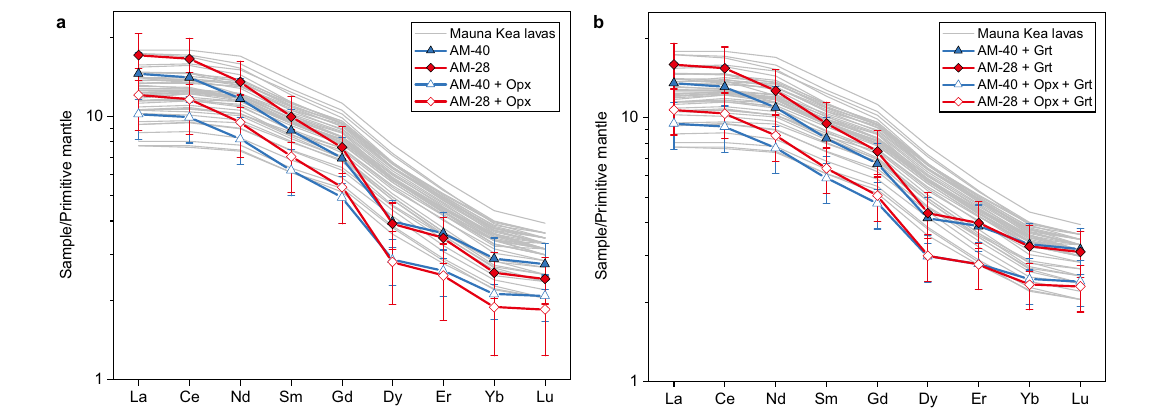
Fig. 3 | The rare earth element patterns of modeled Hawaiian parental melts. a Modeled REE concentrations (normalized to the composition of the primitive mantle 14 )ofmeltsderivedfromtheprimarymeltthroughclinopyroxeneandgarnet precipitation and subsequent orthopyroxene assimilation. b Assuming 10wt% of